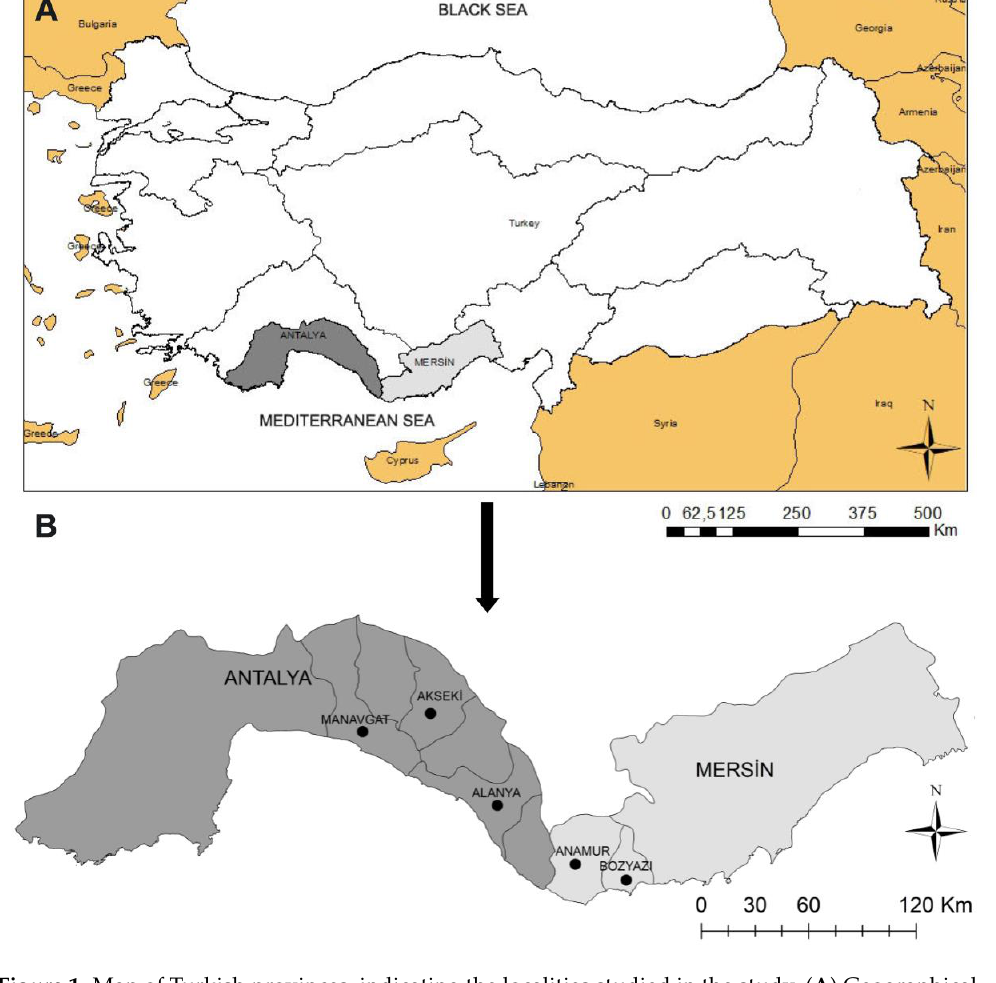
Figure 1. Map of Turkish provinces, indicating the localities studied in the study. ( A ) Geographical position of the prov- inces of Antalya and Mersin in Turkey. ( B ) Position of localities sampled in the provinces of Antalya and Mersin. The sample size was calculated using the online tool Sample Size Calculator (www.calculator.net/sample-sizecalculator.html), for a confidence level (CL) of 95%, an error margin of 5%. According to this, during April–July 2019, a total of 433 apparently healthy small ruminants (296 goats, 137 sheep) were included in the survey. Blood sam- ples were drawn from the punctured jugular vein into anticoagulated (K3-EDTA) vacu- tainer tubes and stored at −20 °C freezer until DNA extraction. The goats and sheep were also checked for tick infestations, and a total of 1475 ticks were removed. The collected ticks were preserved in 70% ethanol in Eppendorf tubes. They were identified using tax- onomic keys [22]. The animals were grouped into categories according to species (goat and sheep) and the presence of ticks (yes/no). This study secured the approval of the Elazig Veterinary Control Institute (number: 2018/02). 2.2. DNA Extraction and Amplification of 16S rRNA Gene DNA was isolated from 200 µL volumes of whole blood using a DNAeasy Blood Minikit according to the vendor’s recommendations. Genomic DNA from blood of clini- cally infected cattle with A. phagocytophilum [6] was used for positive control. Anaplasma